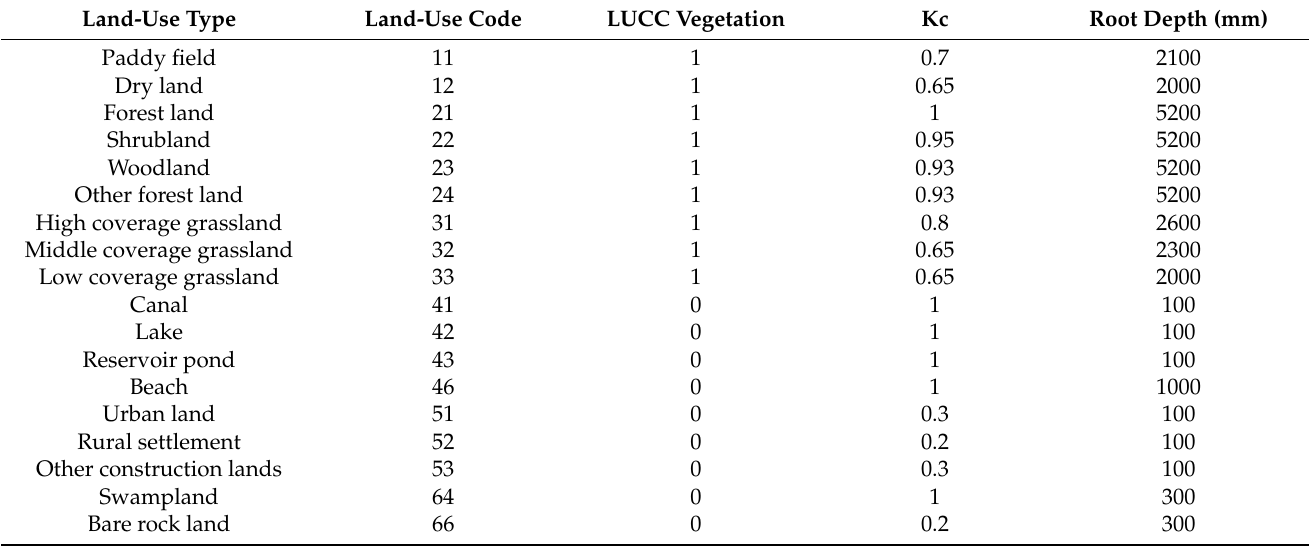
Table 3. The biophysical table used for running the InVEST